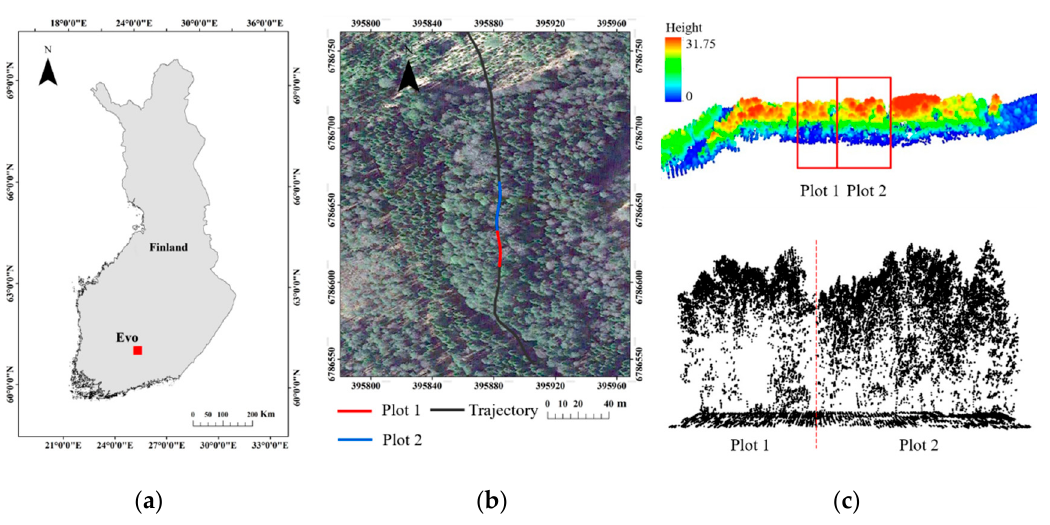
Figure 4. ( a ) Location of the test site, Evo in southern Finland; ( b ) trajectory of data acquisition in the test site (black line) and the selected plot 1 (red line), plot 2 (blue line), in addition, the image only serves as a base map to illustrate the forest conditions and does not mean that it was collected at the same time; ( c ) the lidar point cloud of the two plots.